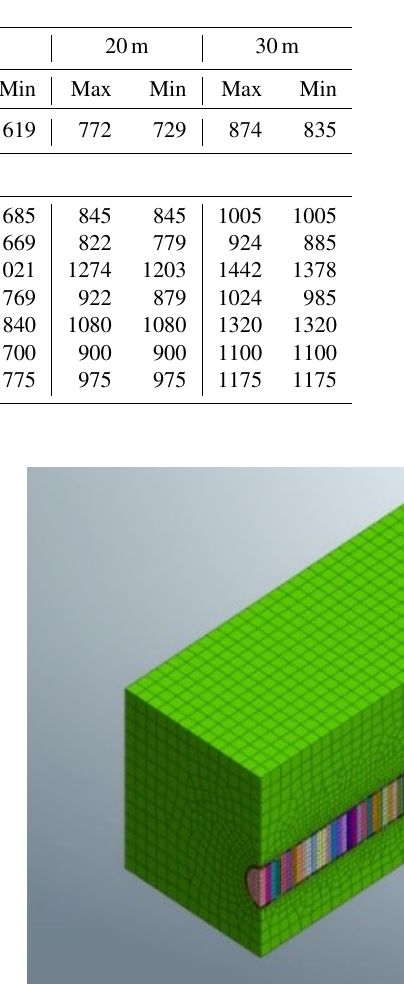
Figure 3. Numerical modelling.